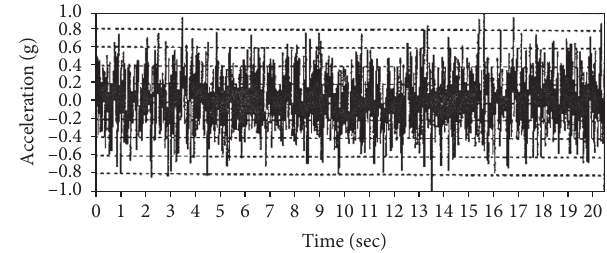
Figure 2: Acceleration function with Gaussian distribution (PGA � 1).